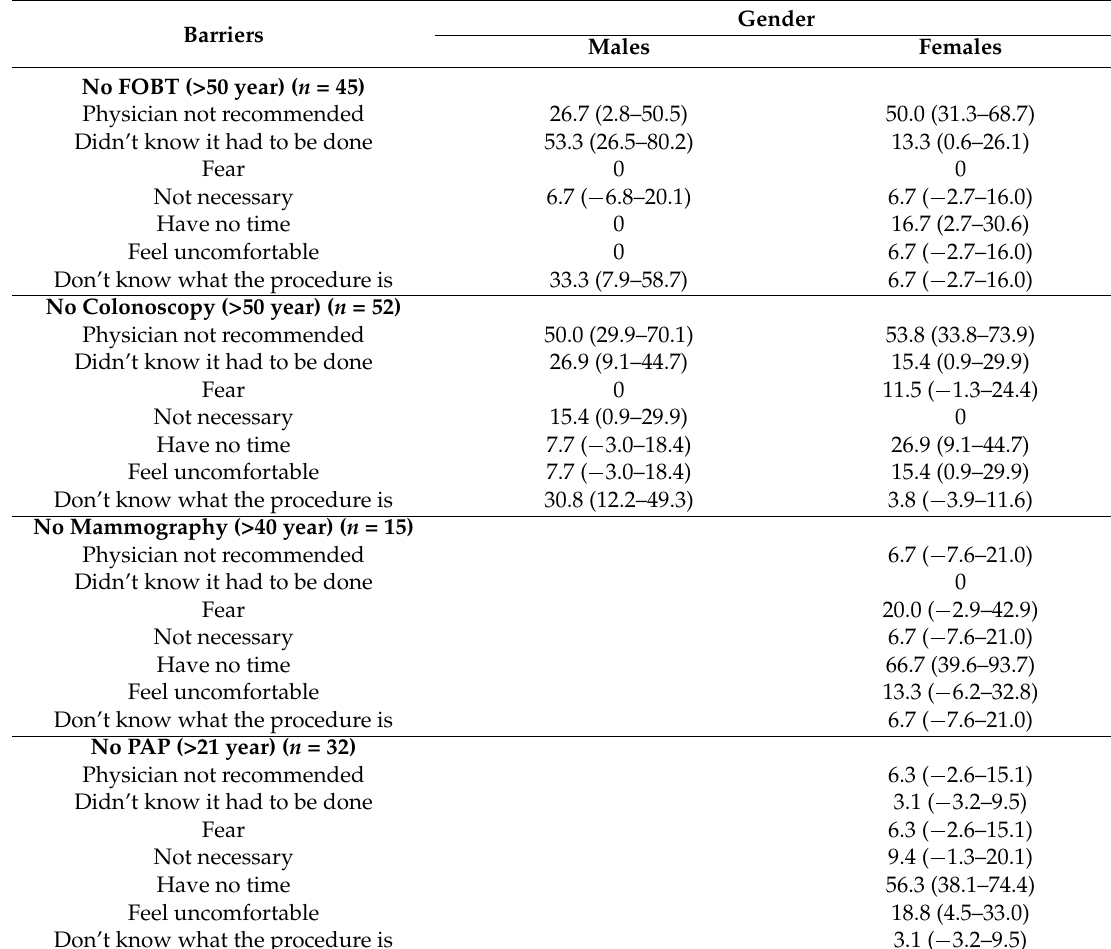
Table 2. Barriers for not undergoing cancer screening tests (95% CI).